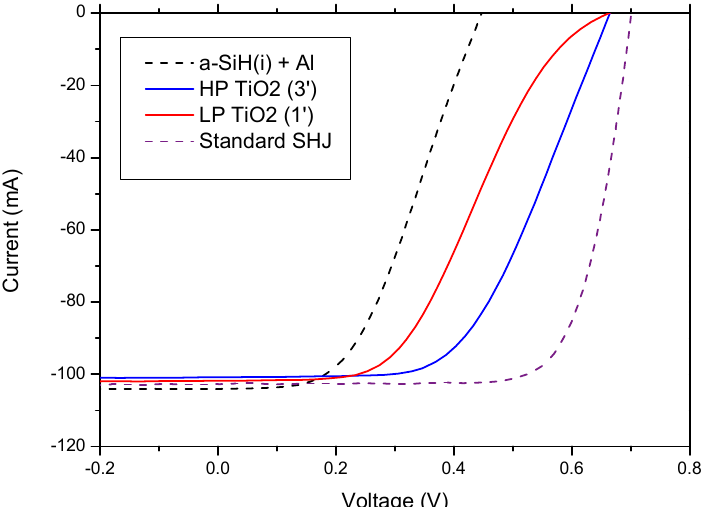
Figure 8. Current-voltage characteristics of the best solar cells fabricated with TiO 2 films deposited in the two pressure regimes studied. For comparison, characteristics of the control solar cell with the aluminum back contact directly evaporated onto the a-Si:H (i) layer and a standard SHJ cell are also included.